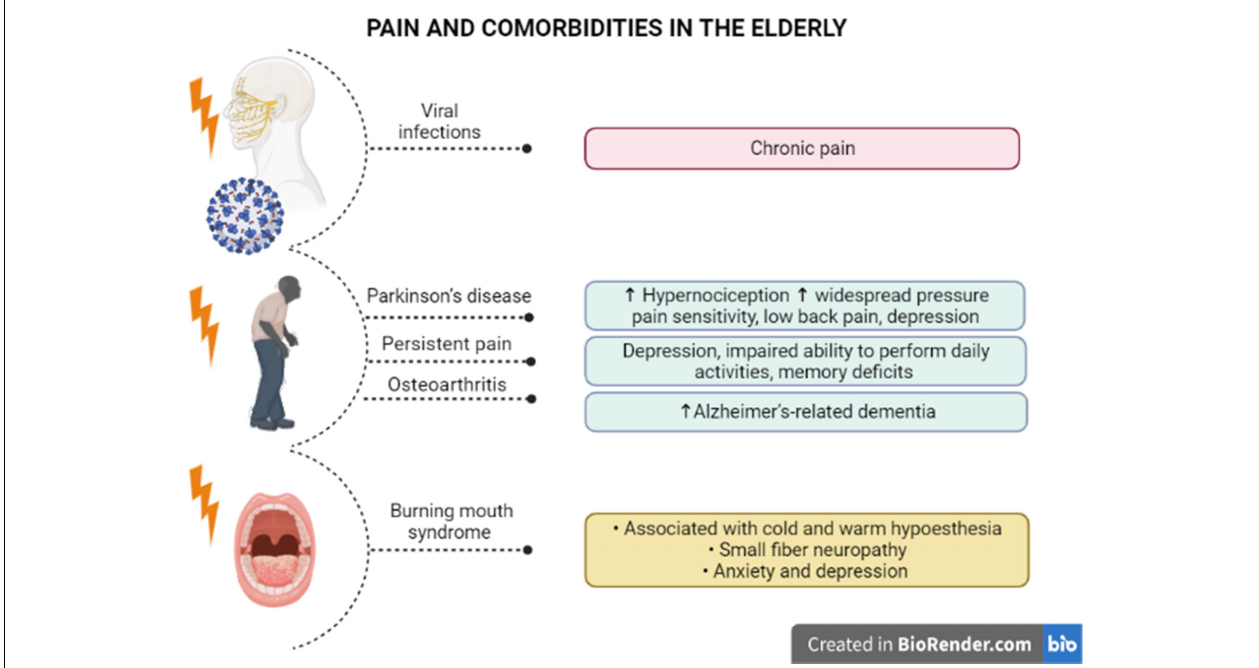
FIGURE 2 | Pain and specific comorbidities in the elderly. There is evidence of a correlation between pain syndromes and comorbidities in older individuals. Viral infections in elder patients with comorbidities has been associated with chronic pain. Parkinson’s disease induces higher hypernociception and widespread pressure pain, low back pain, and depression, and pain likely precedes the motor symptoms. Also, persistent pain has been related to the appearance of depression and memory deficits in older people. It has been proposed that elders with osteoarthritis are at higher risk to develop Alzheimer’s dementia. Older women with burning mouth syndrome diagnosis demonstrated cold and warm hypoesthesia, small fiber neuropathy, with higher levels of anxiety and depression, in a condition that is typically misdiagnosed in